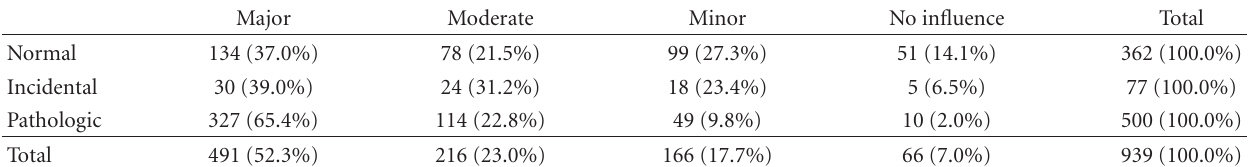
Table 2: Alteration or influence on treatment by 939 radiographic chest examinations, grouped according to chest radiographic outcome. Pathologic studies had the highest rate of influence on treatment